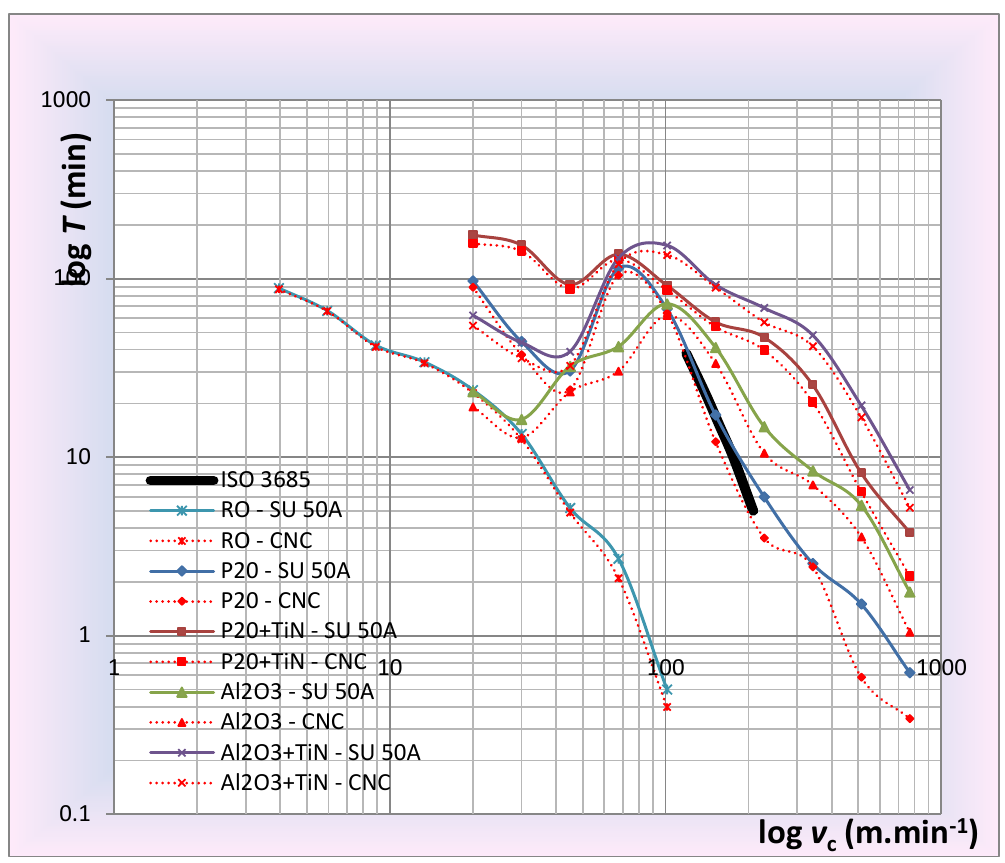
Figure 20. Comprehensive T-vc dependence for all tested cutting materials in logarithmic scale.